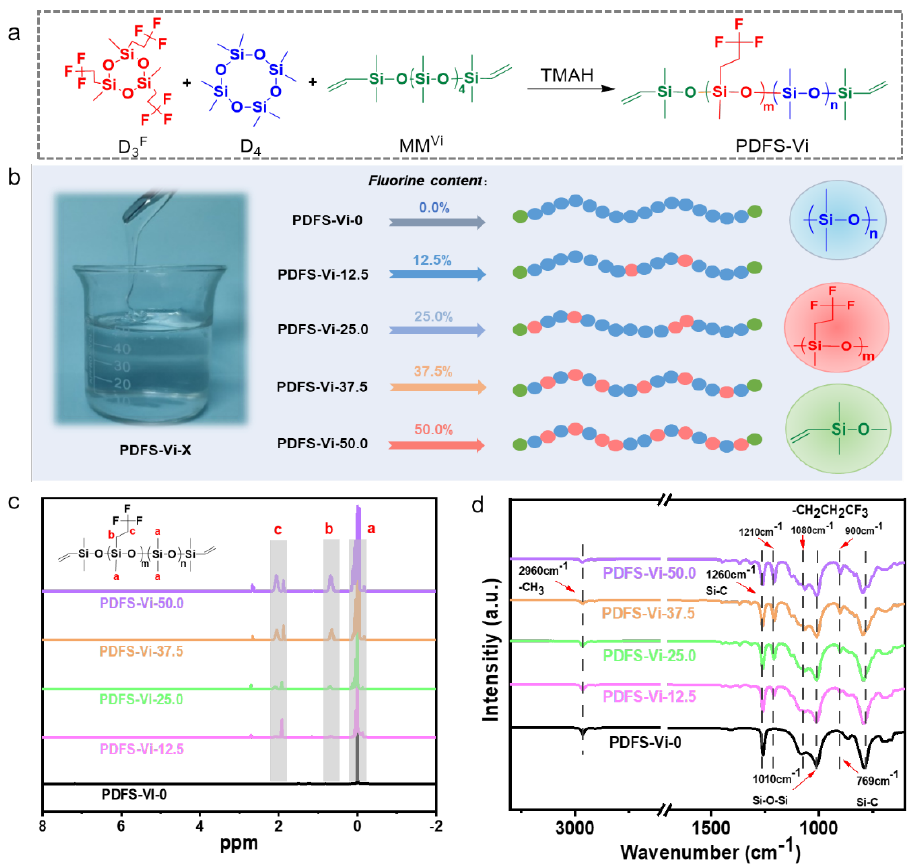
Figure 2. ( a ) Chemical synthesis of PDFS-Vi synthesis process. ( b ) Schematic illustration of the fabrication process of PDFS-Vi-X with different fluorine contents. ( c ) 1 H NMR spectra and ( d ) FTIR spectra of PDFS-Vi-X.